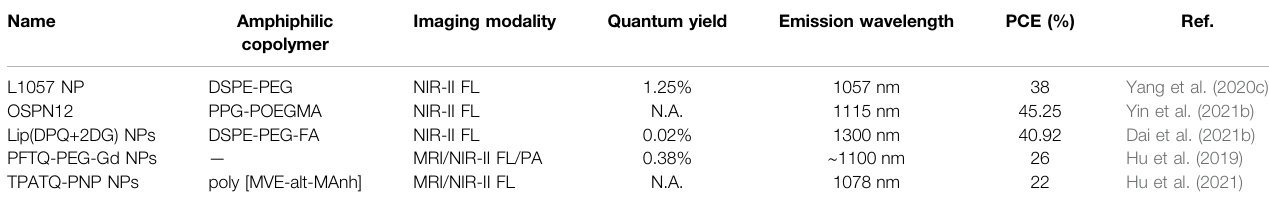
TABLE 2 | Properties of TQ-based SPNs. Name